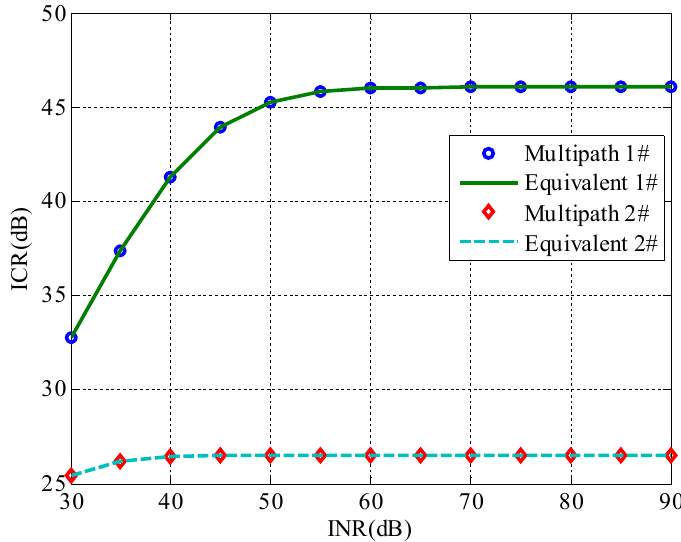
Figure 6. Verification for the equivalent model that used SOP.